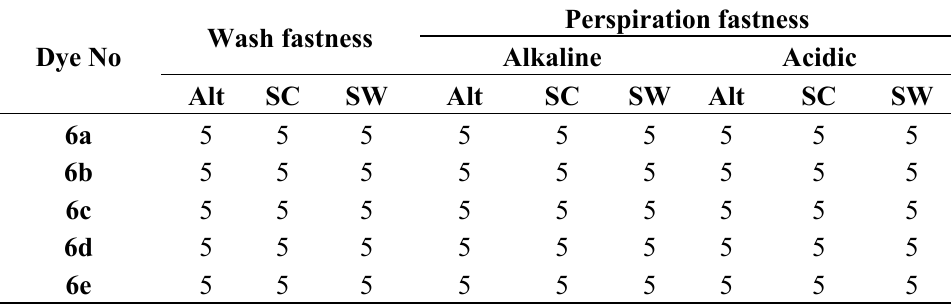
Table 3. Fastness properties of monoazo disperse dyes on polyester fabrics using conventional dyeing method.